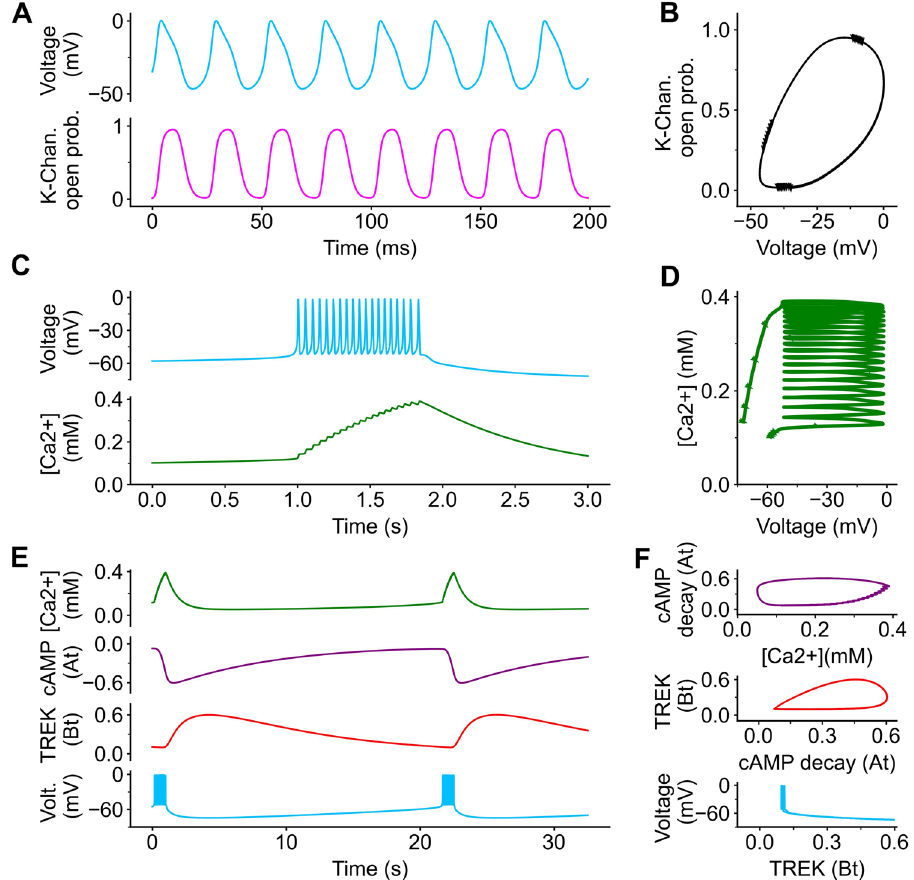
Figure 2. Model traces and oscillations. A 10pA current is added (the equivalence of current clamping a cell) to replicate spiking behavior. In ( A ) As the membrane voltage evolves ( V t ), the potassium channel opening ratio ( N t ). ( B ) These variables (V t and N t ) form a oscillating cycle. ( C ) As the voltage ( V t ) evolves, the influx of intracellular calcium begins to increase ( C t ). The time scale in (C) is in seconds. ( D ) These variables (V t and C t ). also oscillate, but the calcium concentration increases at the same time. ( E ) As calcium ( C t ) evolves, cAMP/ cAMP decay ( A t ), and TREK1 channel activation ( B t ). ( F ) These variables oscillate and eventually lead to an